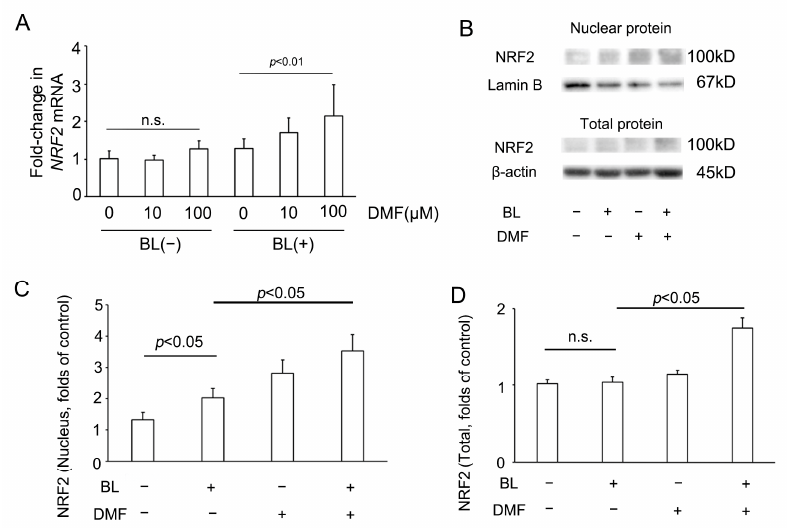
Figure 4. NRF2 expression in ARPE-19 cells on blue-light (BL) exposure. ( A ) In the absence of BL exposure, the NRF2 mRNA level was not increased by DMF. By contrast, on BL exposure, the NRF2 mRNA level was increased by DMF ( n = 8 per group). ( B ) The nuclear and total protein NRF2 expression, as determined by Western blot. ( C ) The NRF2 protein expression in the nucleus was increased by BL exposure and DMF ( n = 6 per group). ( D ) In the absence of BL exposure, NRF2 protein expression in the entire ARPE-19 cell was not increased by DMF. By contrast, on BL exposure, the NRF2 protein expression in the entire ARPE-19 cells was increased by DMF ( n = 6 per group). Statistical analysis was performed using one-way ANOVA, followed by Tukey’s multiple comparisons test where appropriate. NRF2 = nuclear factor (erythroid-derived)-like 2, DMF = dimethyl fumarate, n.s. = not significant.